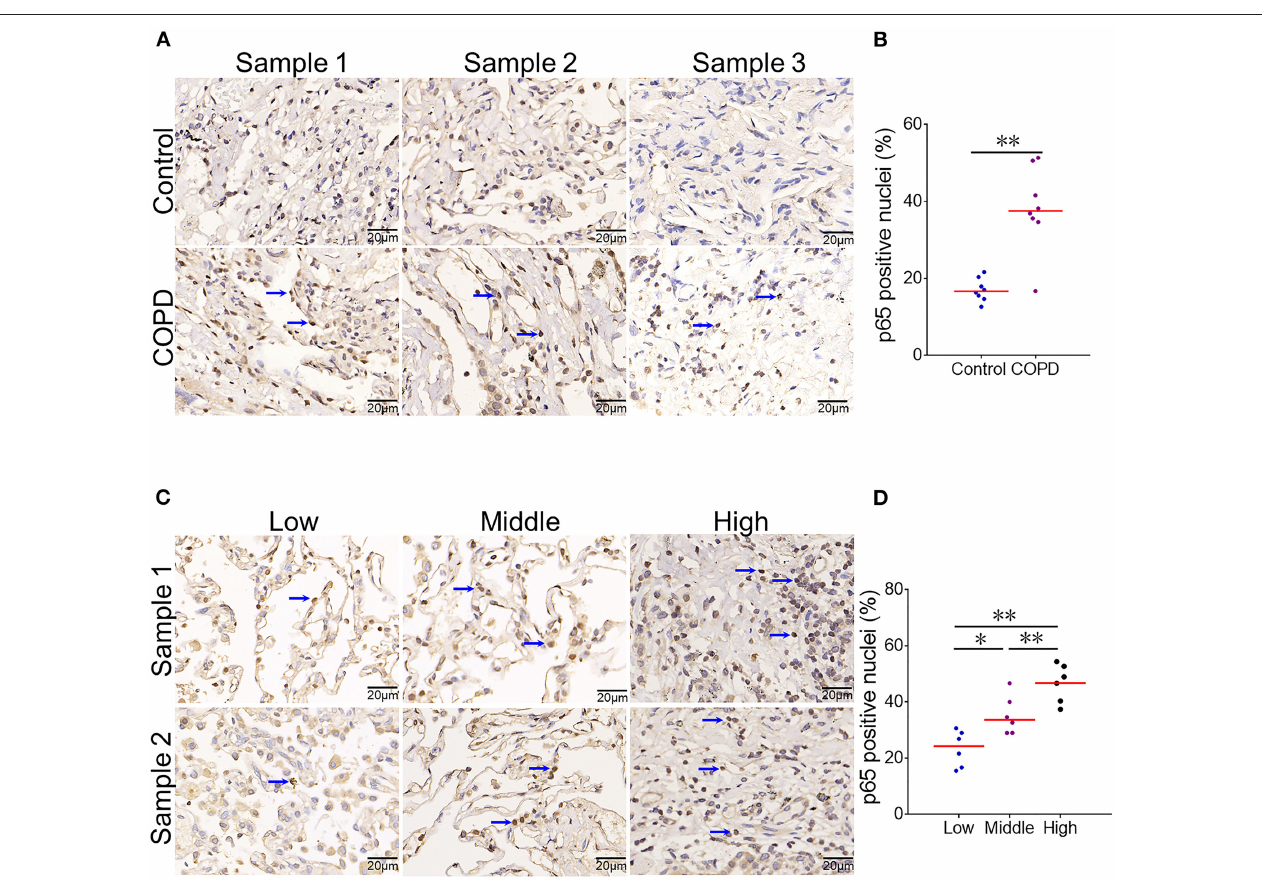
FIGURE 3 | The association between serum CYR61 and pulmonary NF- κ B activation in COPD patients. Lung tissues were collected from COPD patients and controls. Pulmonary NF- κ B p65 was detected using IHC. (A,B) Pulmonary NF- κ B p65-positive nuclei were compared between COPD patients and control subjects. (A) Three representative pictures: arrows indicate p65-positive nuclei; (B) Quantitative analysis of p65-positive nuclei in COPD patients and controls. (C,D) Pulmonary NF- κ B p65-positive nuclei were compared among COPD patients with different levels of CYR61. (C) Three representative pictures: arrows indicate p65-positive nuclei; (D) Quantitative analysis of p65-positive nuclei in COPD patients with different levels of CYR61. All data were represented as means ± S.E.M. ( N = 6). * P < 0.05, ** P < 0.01.